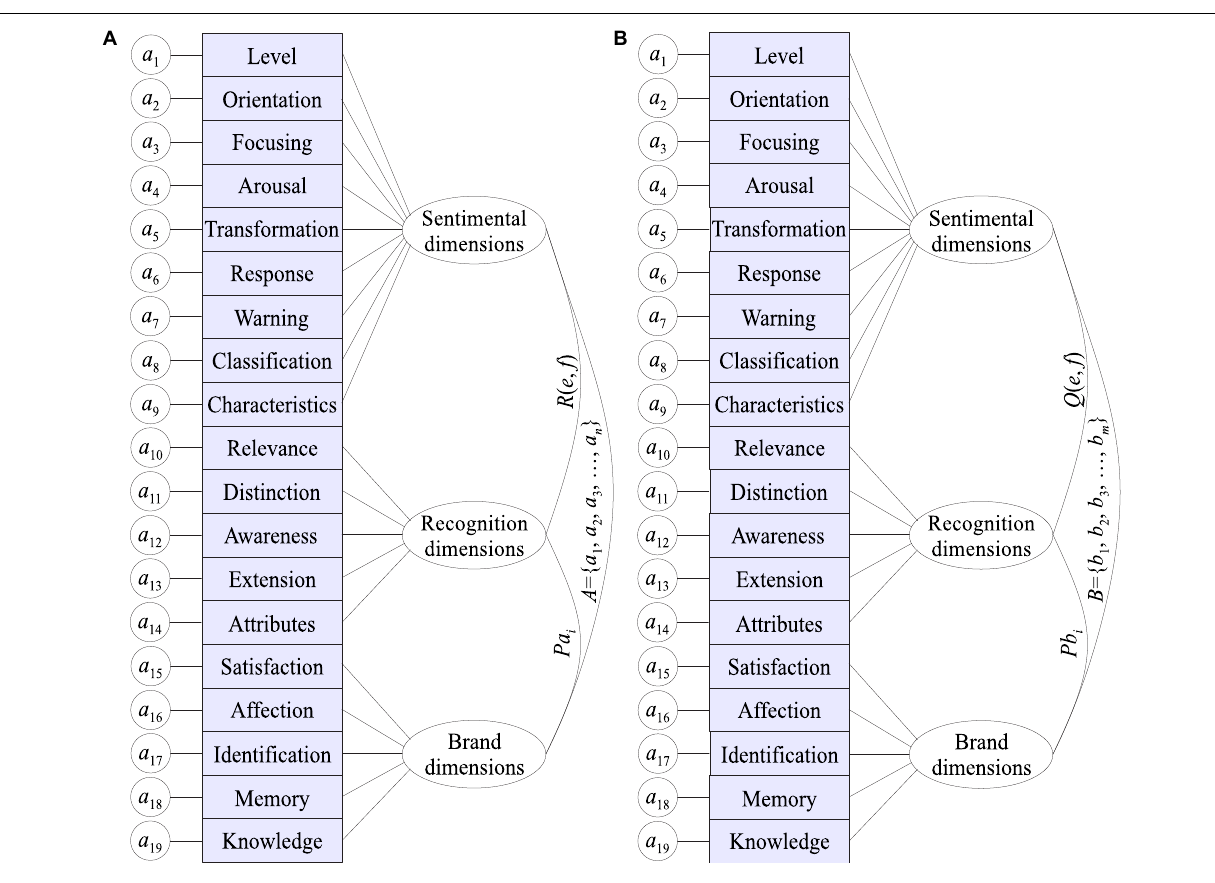
FIGURE 2 | Information receiving and processing hierarchy of the quantitative model of brand recognition based on sentiment analysis of big data (A) Information receiving hierarchy, (B) Information processing